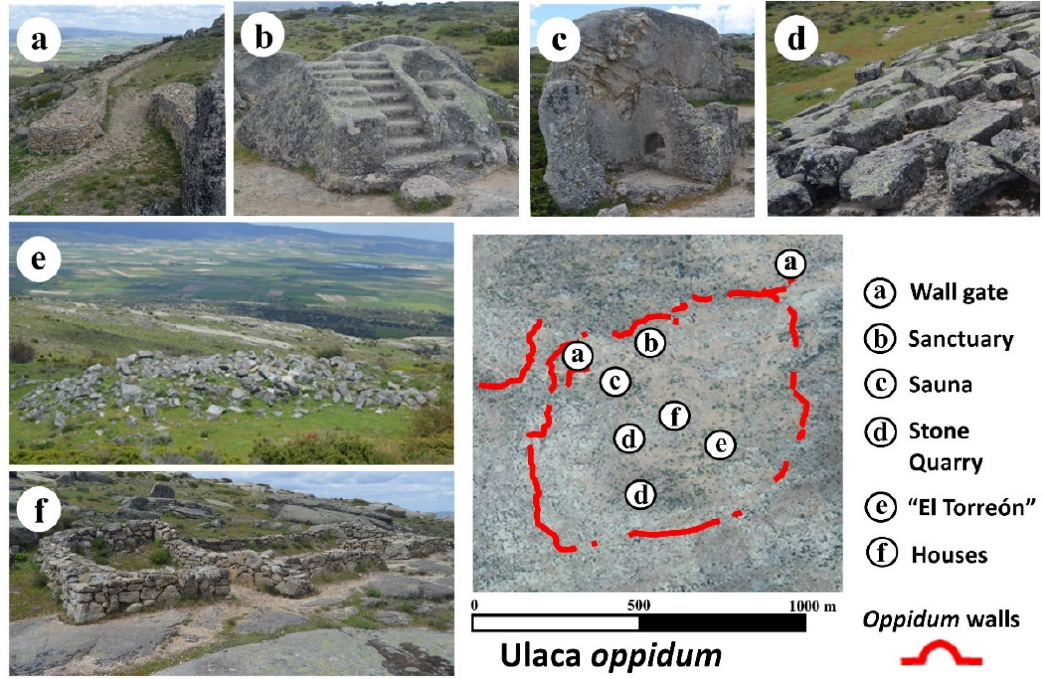
Figure 2. Principal monuments found within the Ulaca oppidum.